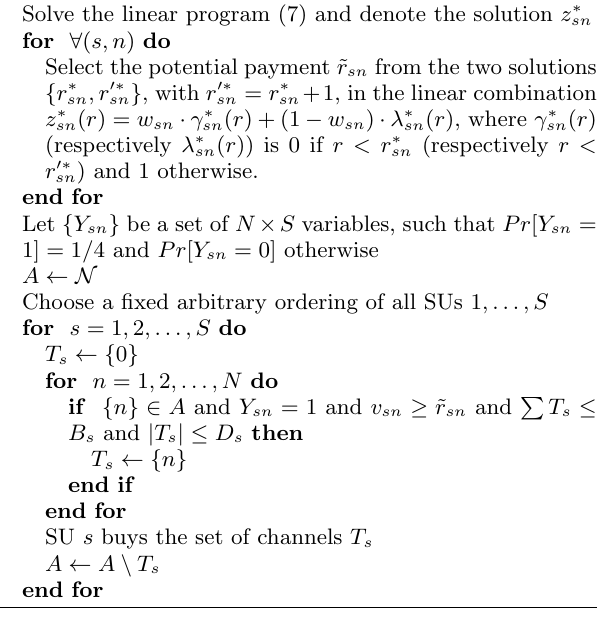
Algorithm 1 Sequential Arbitrary-order